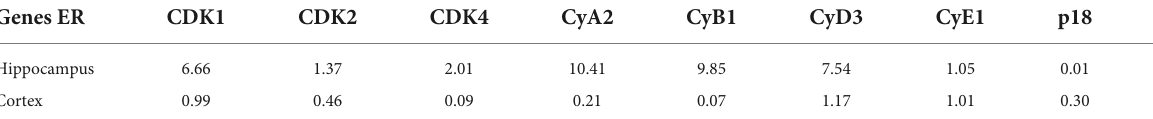
ER,encephalicregion.